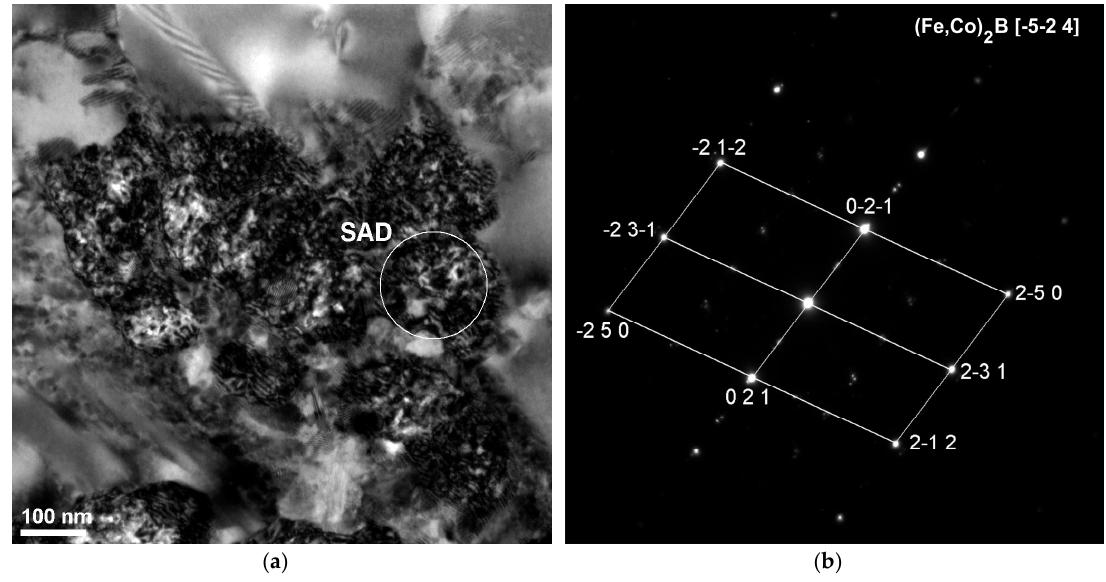
Figure 10. TEM image of the Fe 36.00 Co 36.00 B 19.00 Si 5 Nb 4 Fe 35.75 Co 35.75 B 18.90 Si 5 Nb 4 Cu 0.6 alloy in rod form with the diameter of 2.5 mm, ( a ) bright field; ( b ) the electron diffraction from the position marked SAD in (a); solution of diffraction: (Fe,Co)B 2 phase.